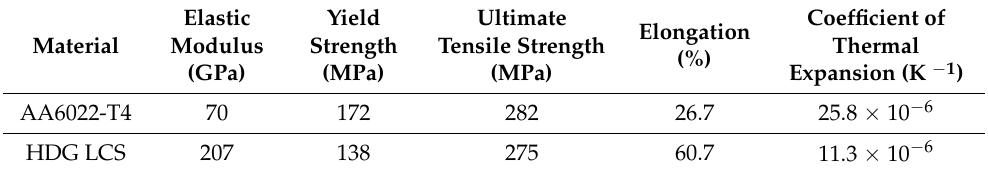
Figure 4. ( a ) Schematic of the finite element model of the coach peel weld specimen including geometry dimensions (unit: mm), and ( b ) hardness informed model with nugget area mapped from the cross-section geometry. Table 2. Mechanical properties of AA6022-T4 and HDG LCS at room